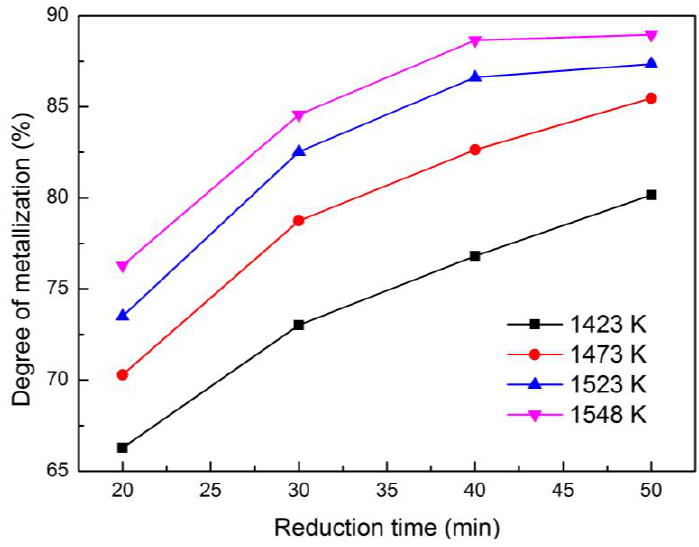
Figure 2. Effects of time on the degree of metallization of reduced briquettes at different temperatures.